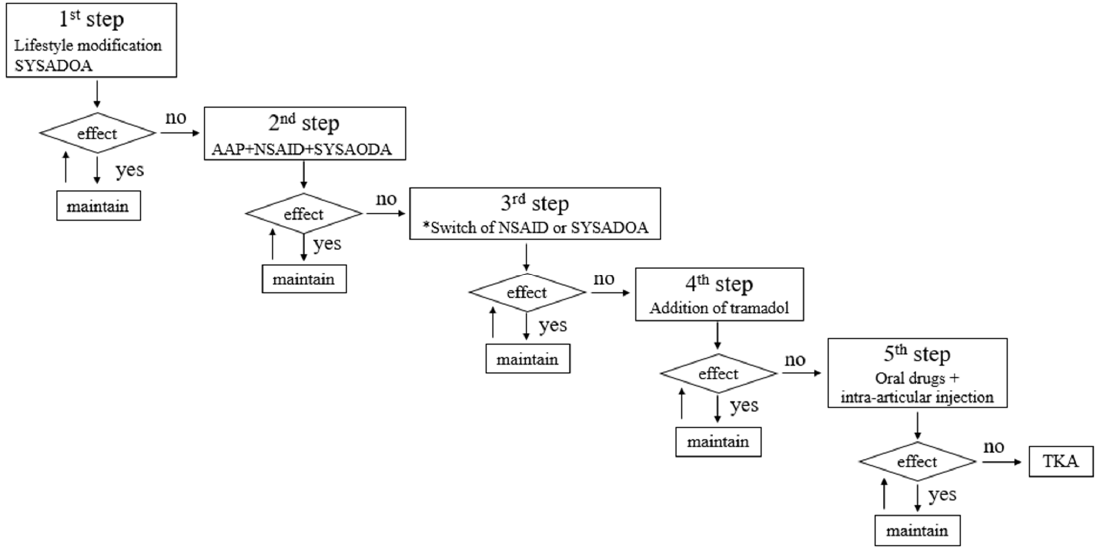
Figure 2. Diagrammatic representation of the treatment protocol. The e ff ect was evaluated using a NRS. If the NRS remained >4 after 2–3 weeks, the next step was performed. (NRS: Higher scores indicate more pain.) * Switching a speci fi c drug was based on previous exposure to speci fi c NSAIDs and SYSADOAs. NRS, numeric rating scale; NSAID, non-steroidal anti-in fl ammatory drug; SYSADOA, slow-acting drug for osteoarthritis; AAP, acetaminophen; TKA, total knee arthroplasty.